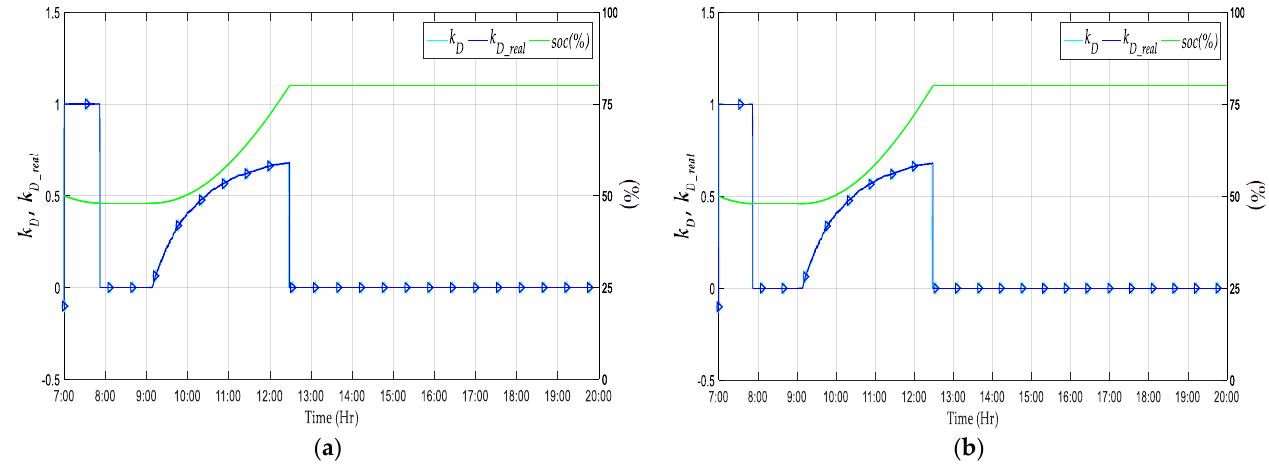
k , , and soc with optimization by applying the  coefficient in Figure 14. Evolution of Figure 14. Evolution of k D , k D _ real , and soc with optimization by applying the γ coefficient in the D